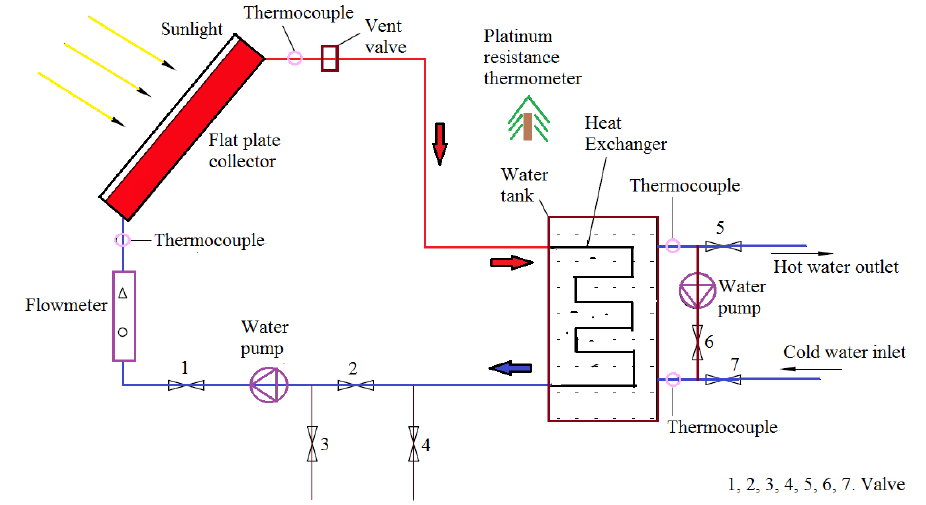
Fig. 2. Experimental setup of solar thermal energy measuring system